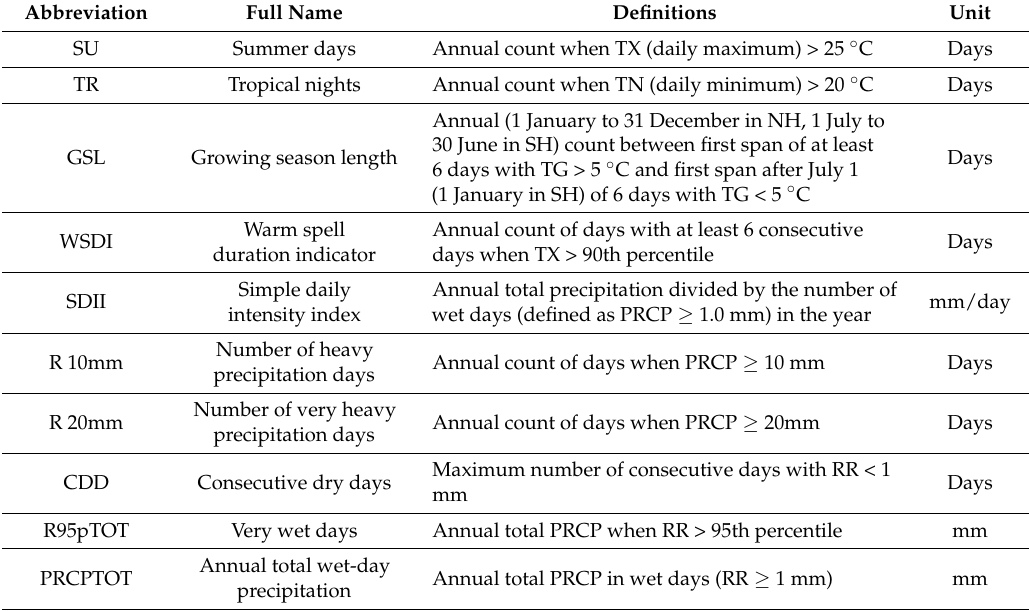
Table 2. Definitions of the extreme climate